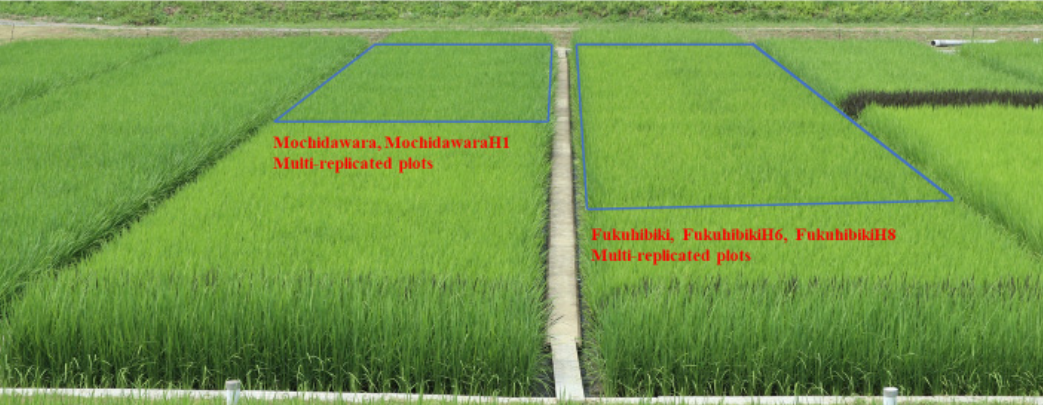
Figure 3. Multi-replicated yield trial plots of MochidawaraH1, FukuhibikiH6, and FukuhibikiH8 at maximum tillering stage in paddy fields in Ibaraki, Japan, in 2018.